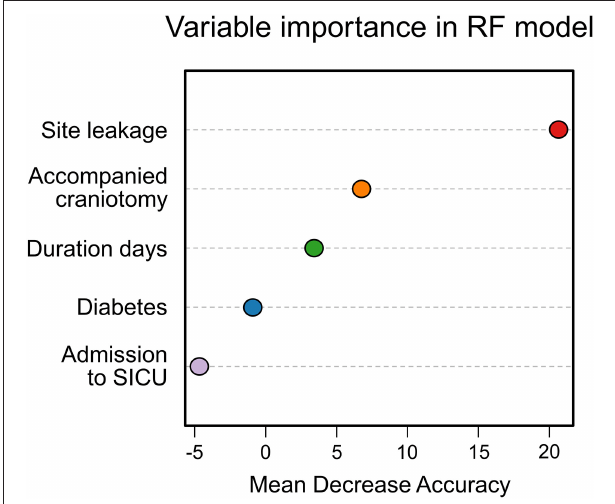
FIGURE 5 | The importance of features in the random forest (RF) model. Site leakage showed the most considerable mean decrease in